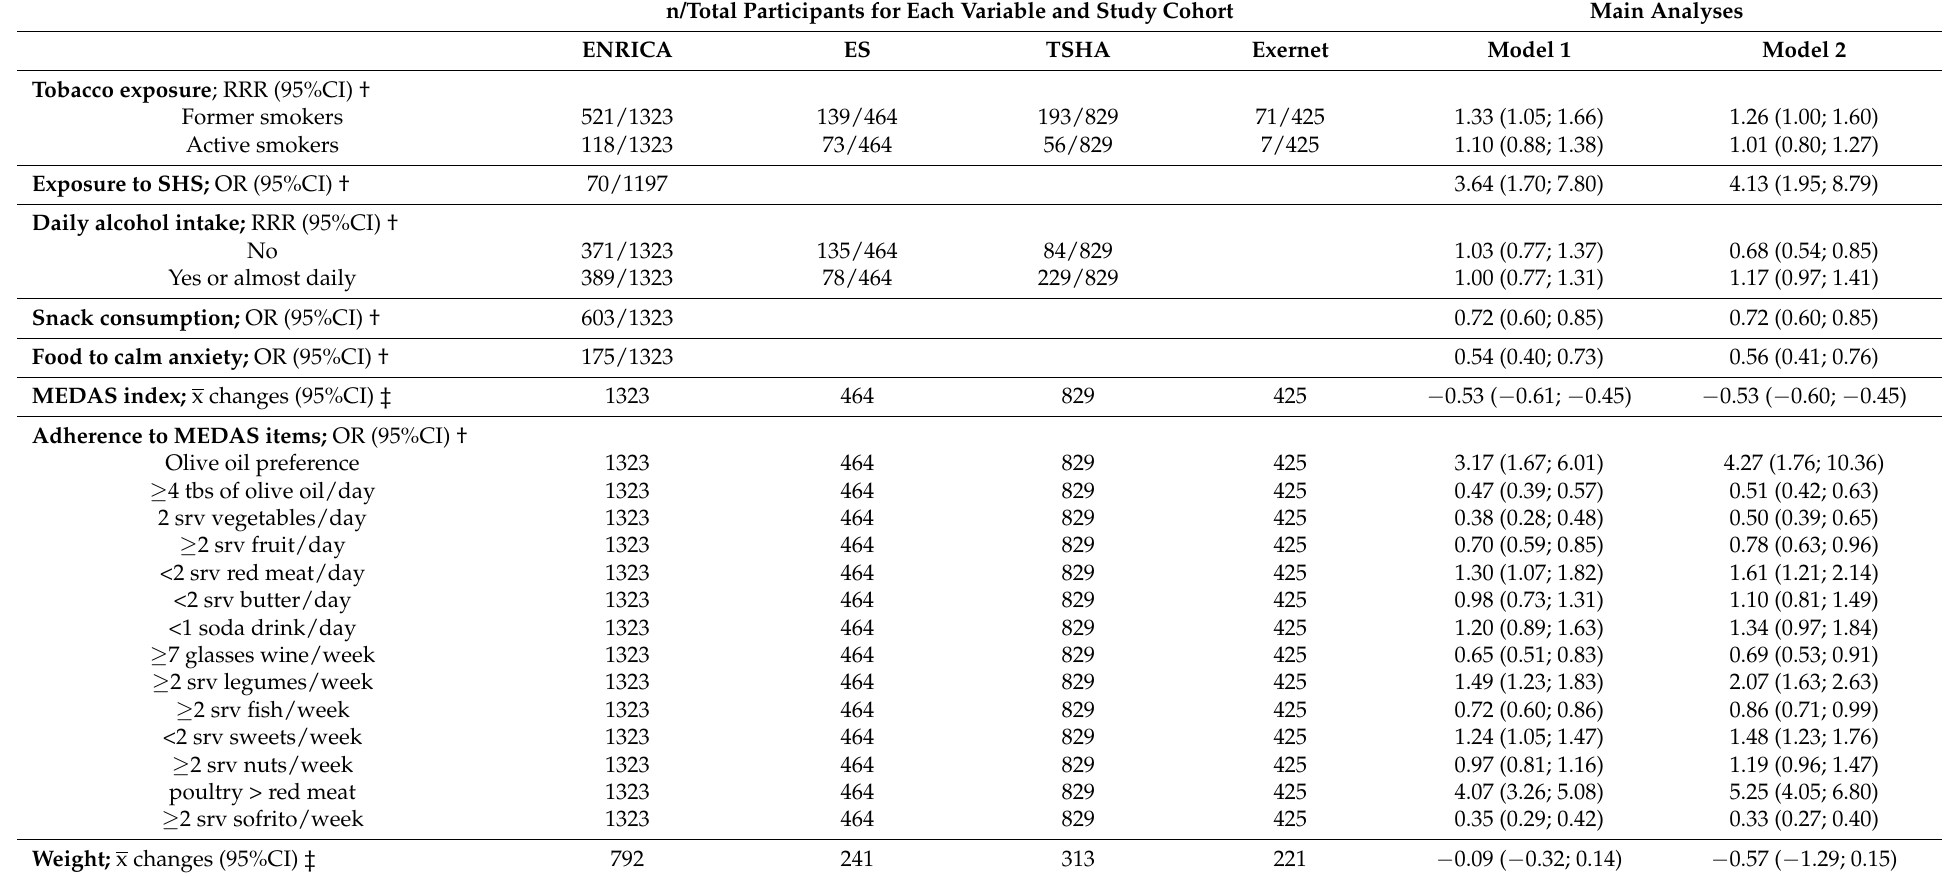
Table 1. Longitudinal changes in the prevalence of smoking, second-hand smoke, alcohol intake, diet quality, physical activity, weight, sedentary time, sleep characteristics, overall health, and pain between the COVID-19 pre-confinement (t0) and the confinement (t1)